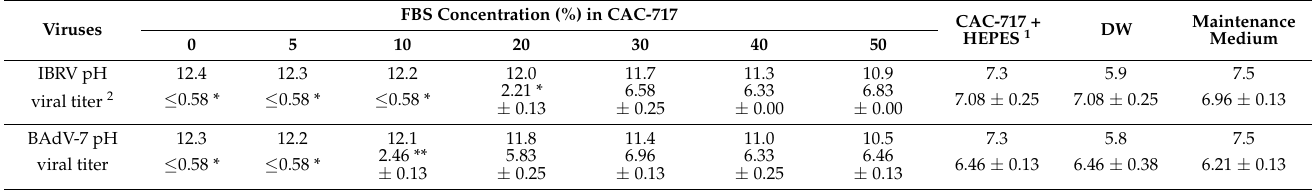
Table 4. Effect of FBS on the virucidal effects of CAC-717 on IBRV as a representative enveloped virus and BAdV-7 as a representative non-enveloped